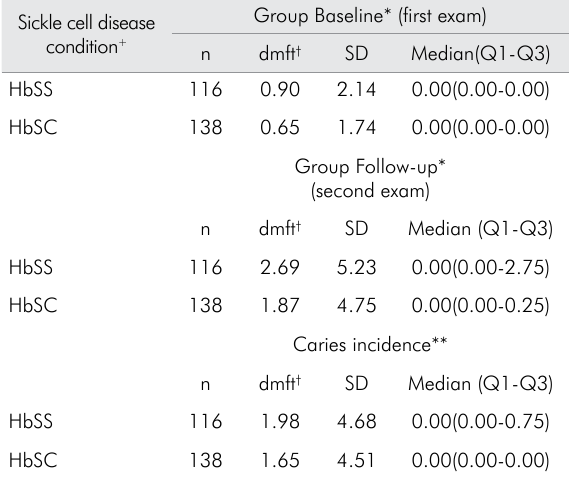
Table 1. Measures of central tendency and dispersion dmft second most significant genotypes of sickle cell disease in children 6-60 months in